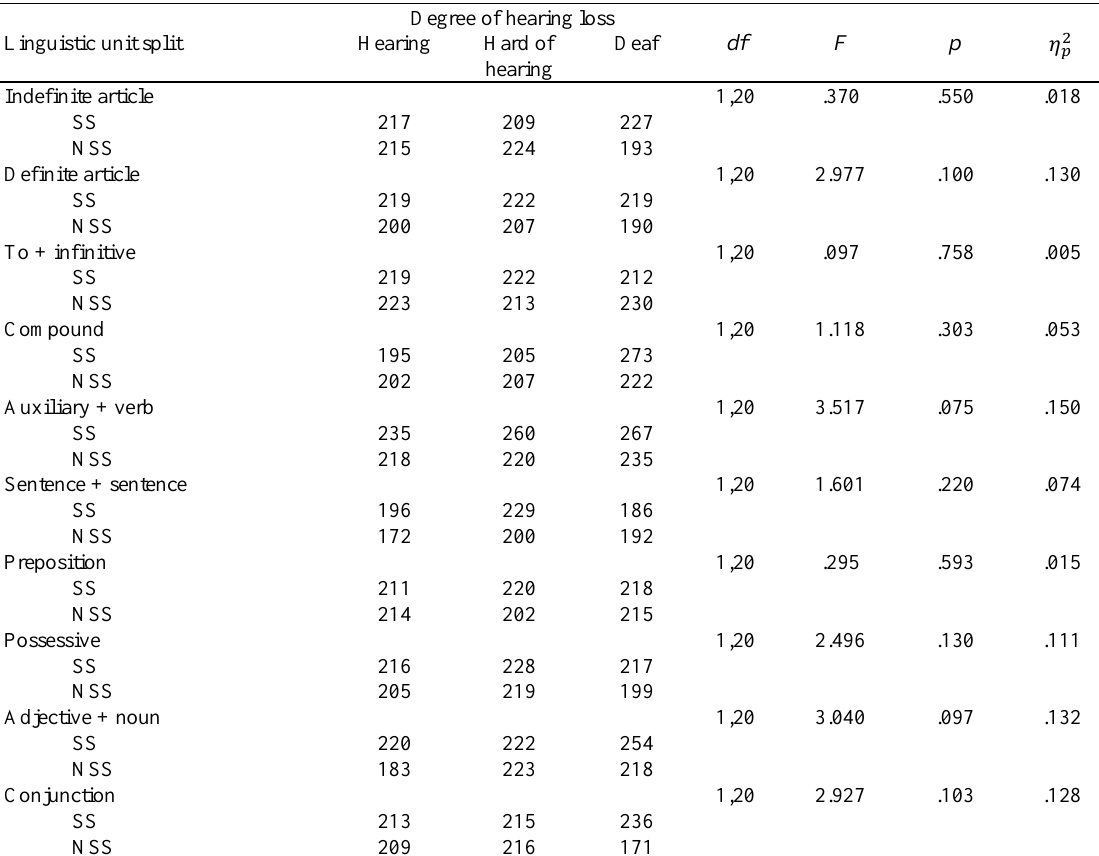
Table 10. Mean Fixation Duration by linguistic unit and